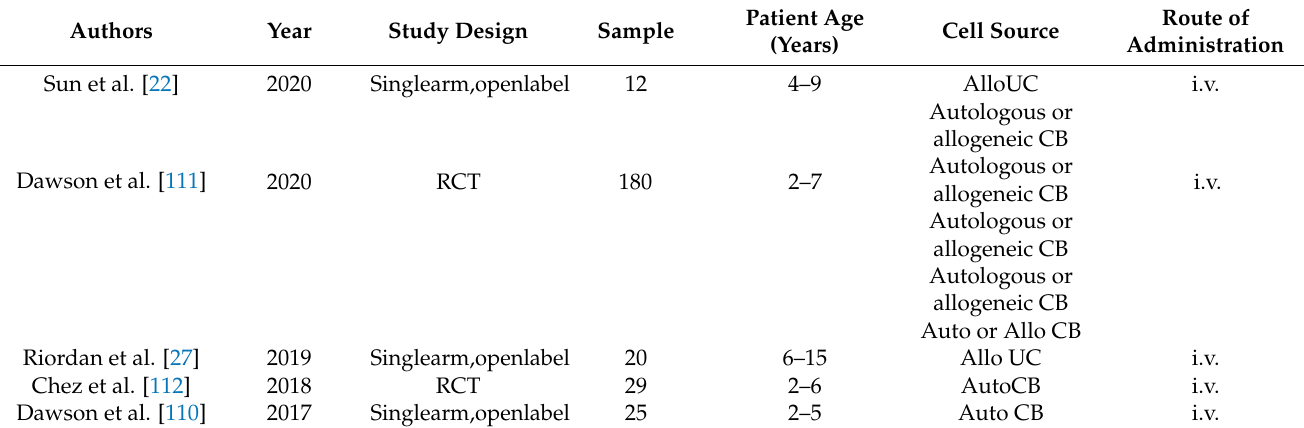
Table 3. Clinical trials of cell therapies in autism spectrum